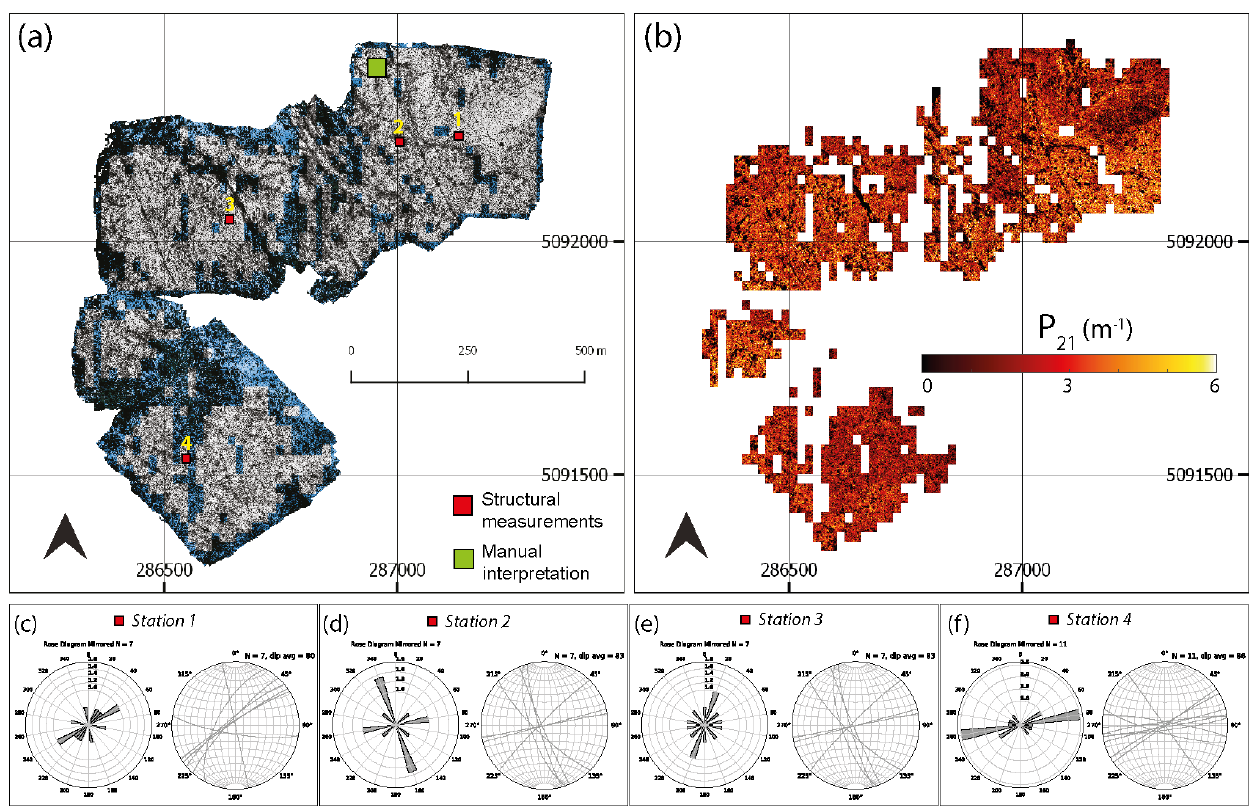
Figure 8. Trace extraction results from the Parmelan. (a) Selected tiles from the orthomosaic (Prabhakaran et al., 2019b) spatial extent are highlighted. Points where structural measurements were collected (stations) are depicted using red squares. The region where there is a comparison between manual and automatic interpretations is highlighted by the green square. (b) Spatial variation in the fracture intensity depicted as a P 21 plot computed using the box counting method. (d) Rose and stereoplot of Station 1. (e) Rose and stereoplot of Station 2. (e) Rose and stereoplot of Station 3. (f) Rose and stereoplot of Station 4. The Parmelan dataset (Prabhakaran et al., 2019b) is available under a CC-BY-NC-SA